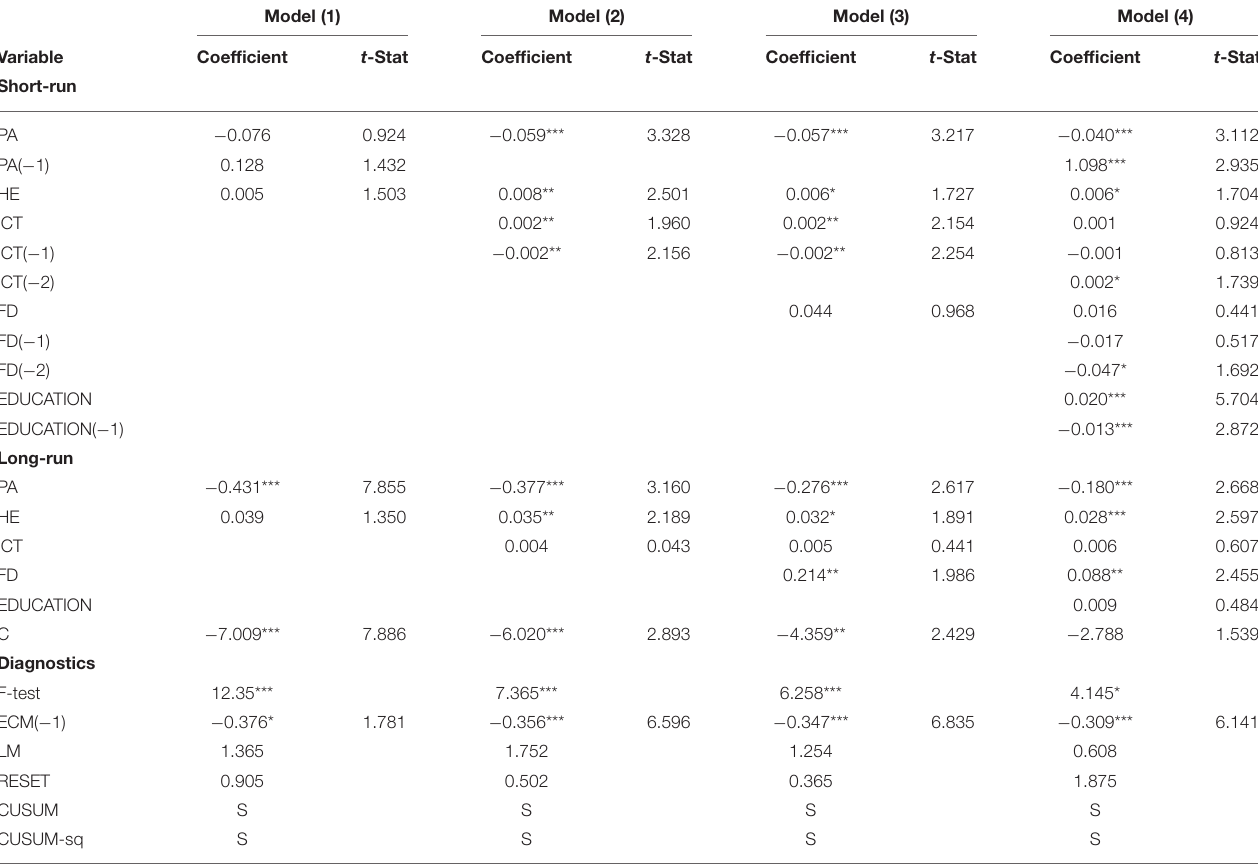
TABLE 3 | Long and short-run estimates of human